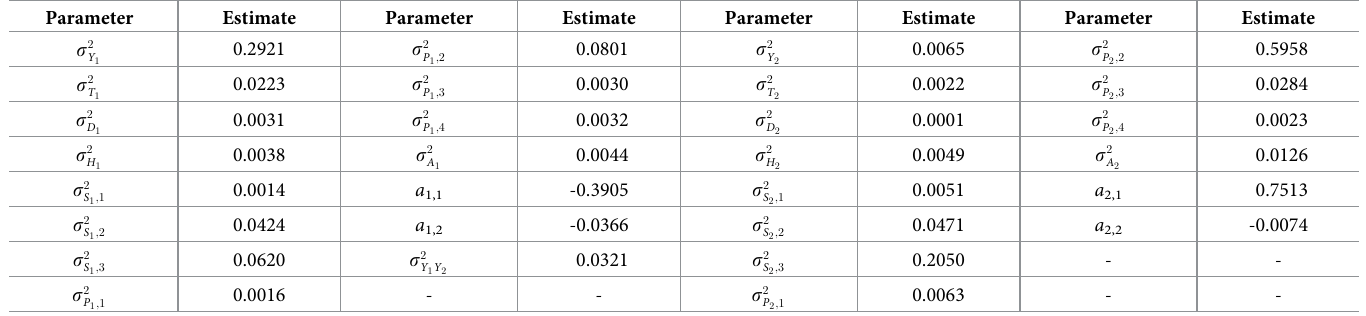
Table 3. Parameter